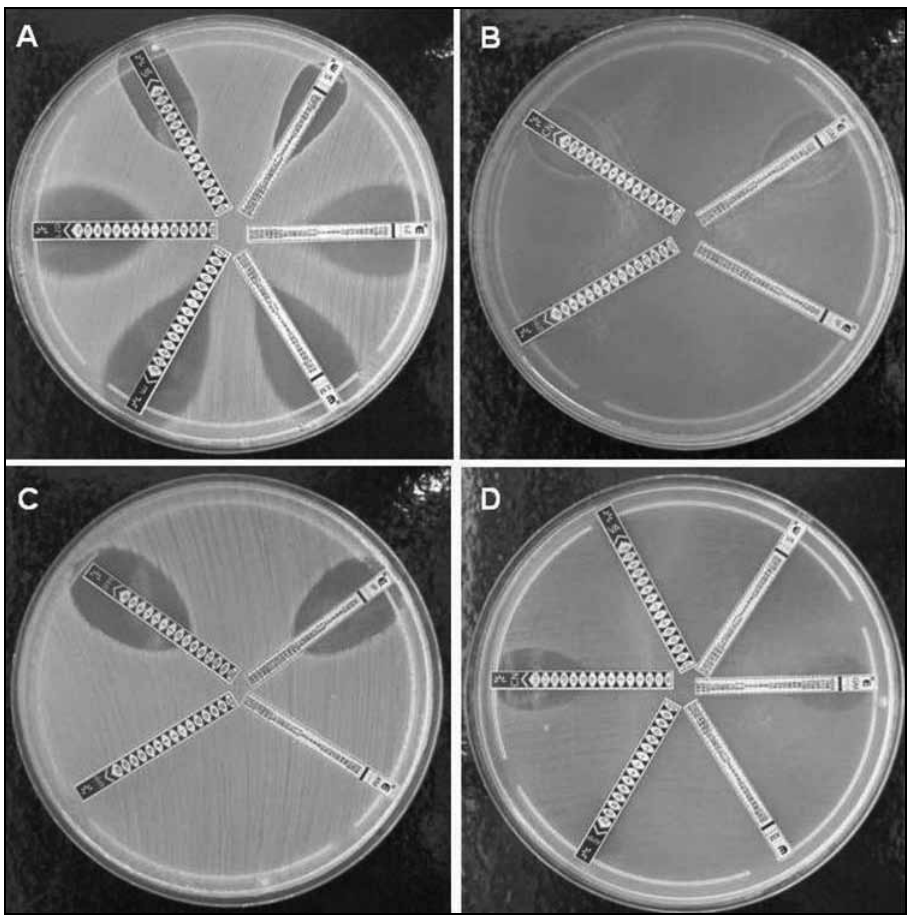
Figura – Teste de sensibilidade a antimicrobianos pelas fitas MICE e Etest. (A) S. aureus: VA, vancomicina; LZD, linezolida; LZ, linezolida; E, eritromicina; EM, eritromicina; (B) P. aeruginosa: CN, gentamicina; GM, gentamicina; IPM, imipenem; IP,